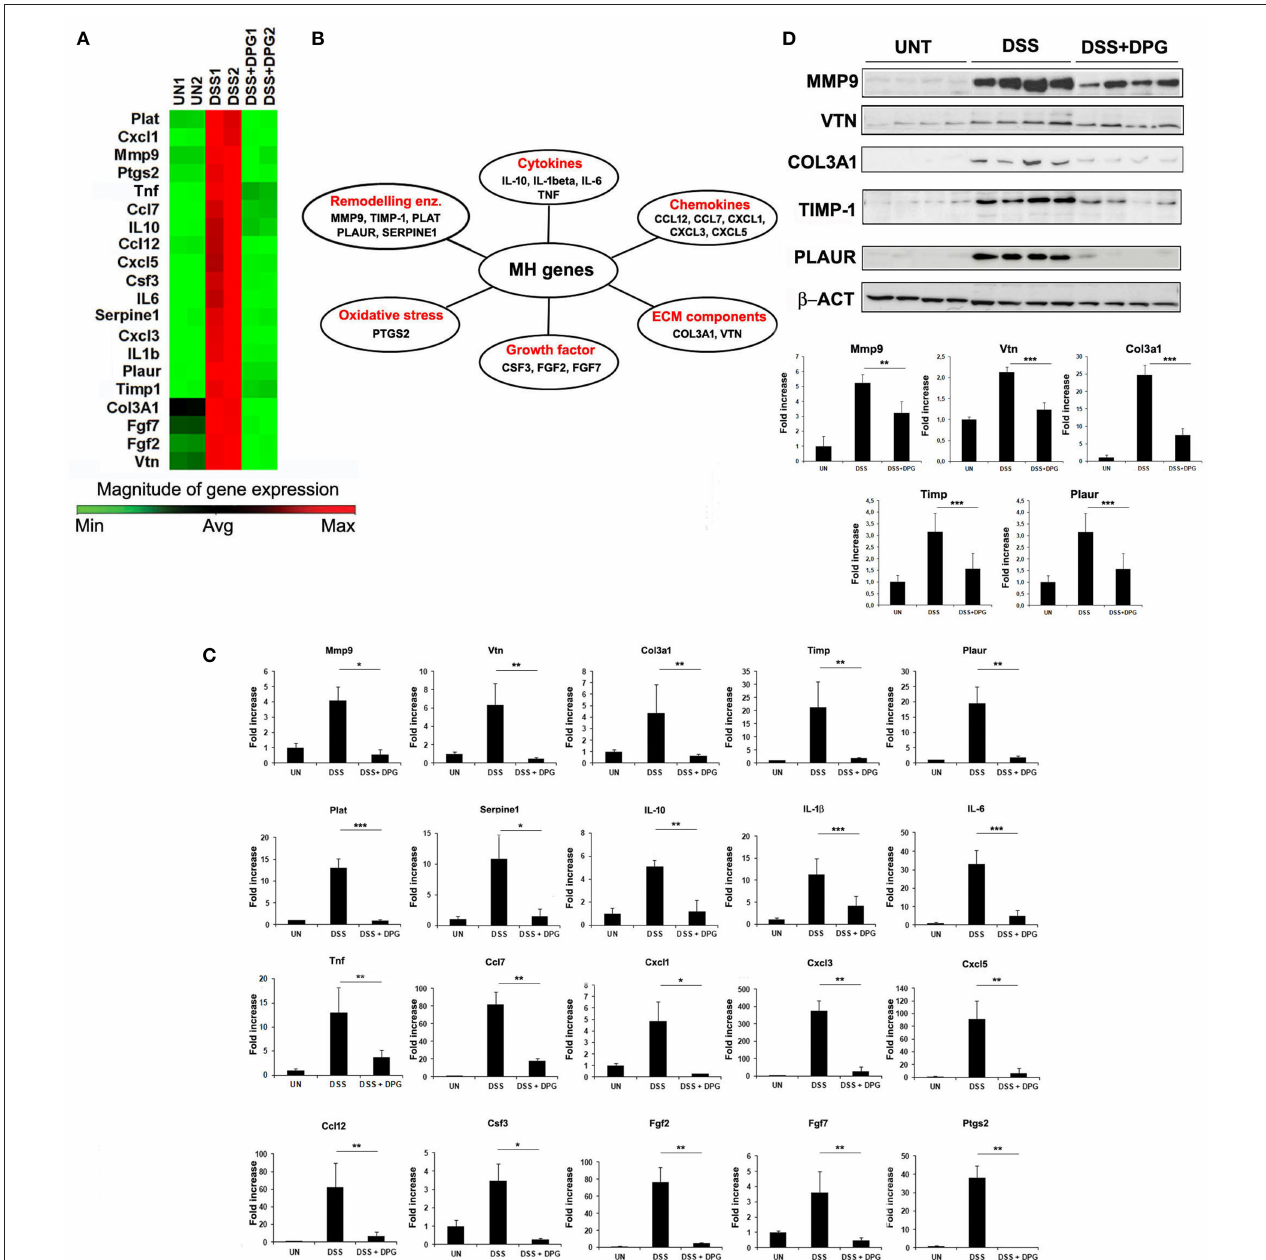
FIGURE 1 | Identification and validation of genes, involved in MH pathways, modulated by DPG in inflamed tissues of mice with experimental acute colitis. (A) Genes activated by DSS and inactivated by DPG treatment in vivo , identified by PCR-Array, and (B) their classification in functional groups. (C) mRNA expression of all identified genes, modulated by DPG in mice with DSS acute colitis, were validate by quantitative real-time PCR. Statistical analysis: Kruskal-Wallis Test with Dunn’s Multiple Comparisons post-Test . (D) Protein expression of some identified genes was confirmed by western blot, using 8 animals per group. Statistical analysis: Kruskal-Wallis Test with Dunn’s Multiple Comparisons post-Test . * p < 0.05, ** p < 0.01, *** p < 0.001. PCR-Array was repeated in triplicate using a pool of RNA obtained from 5 animals per group. Real-time PCR values are mean ± St. dev. of 8 animals per experimental group and data represent the target gene expression normalized to the reference gene. UN, untreated animals; DSS, dextran sulfate sodium; DPG, dipotassium glycyrrhizate.